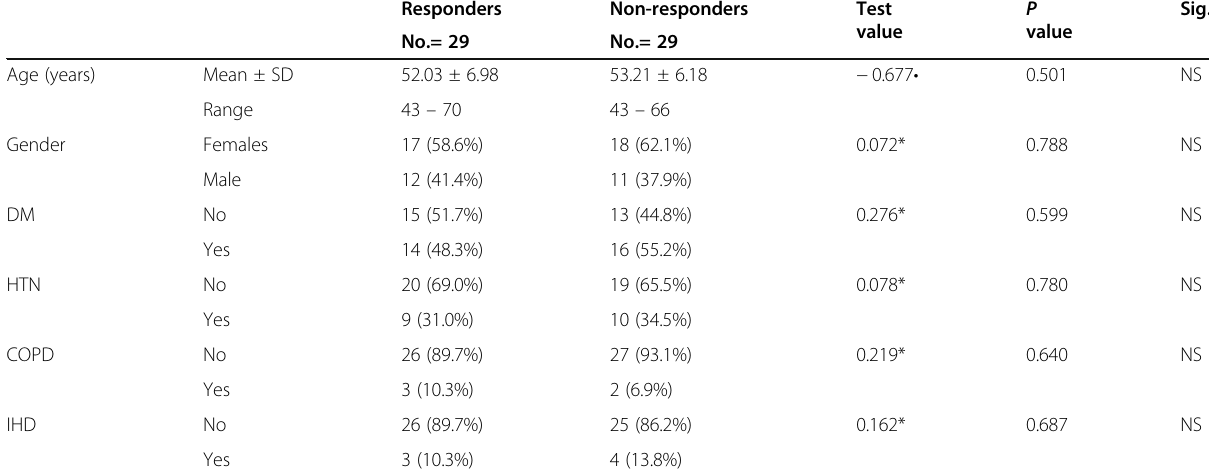
Table 1 Comparison between responders and non-responders regarding demographic data and risk factors Responders